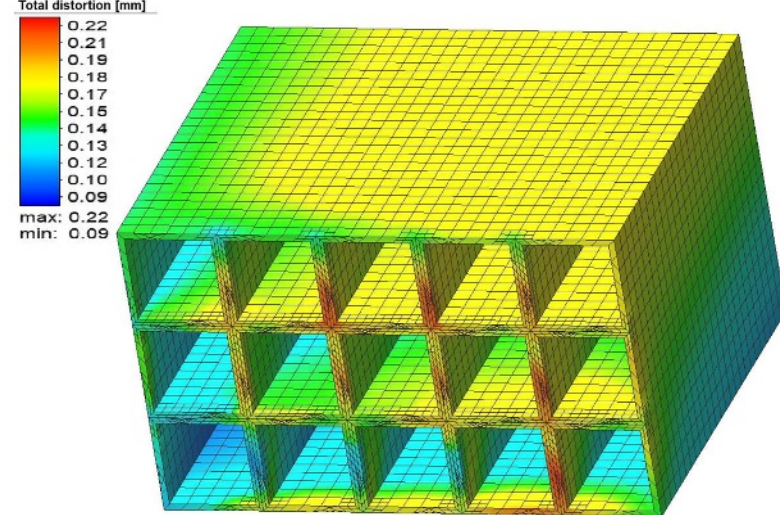
Figure 24 . Welding induced distortion in vent panel .